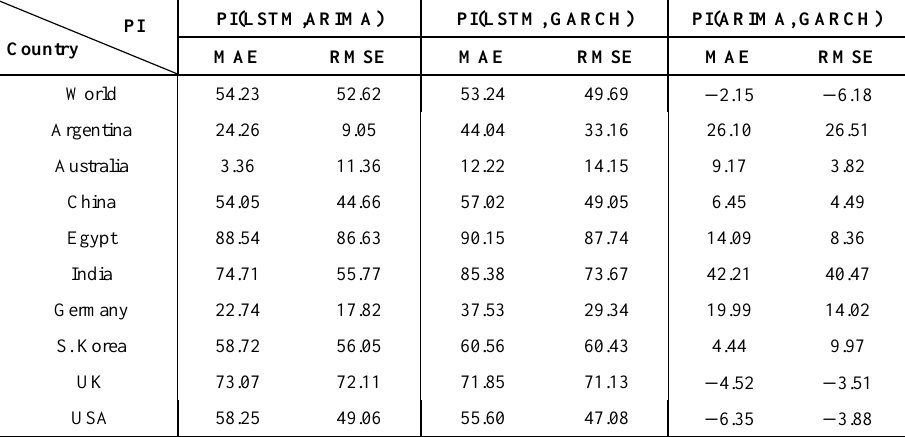
Table 4. Comparison of percentage improvement ( r = 0.8, unit: